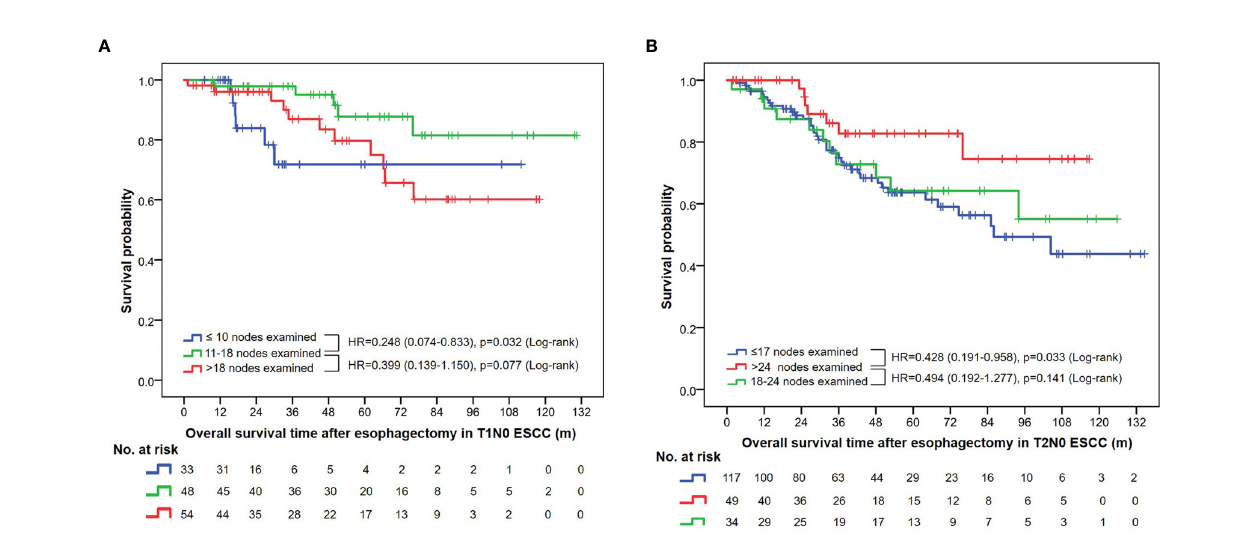
FIGURE 4 | (A) Overall survival curves in T1N0 ESCC patients strati fi ed by the number of nodes examined. (B) Overall survival curves in T2N0 ESCC patients strati fi ed by the number of nodes